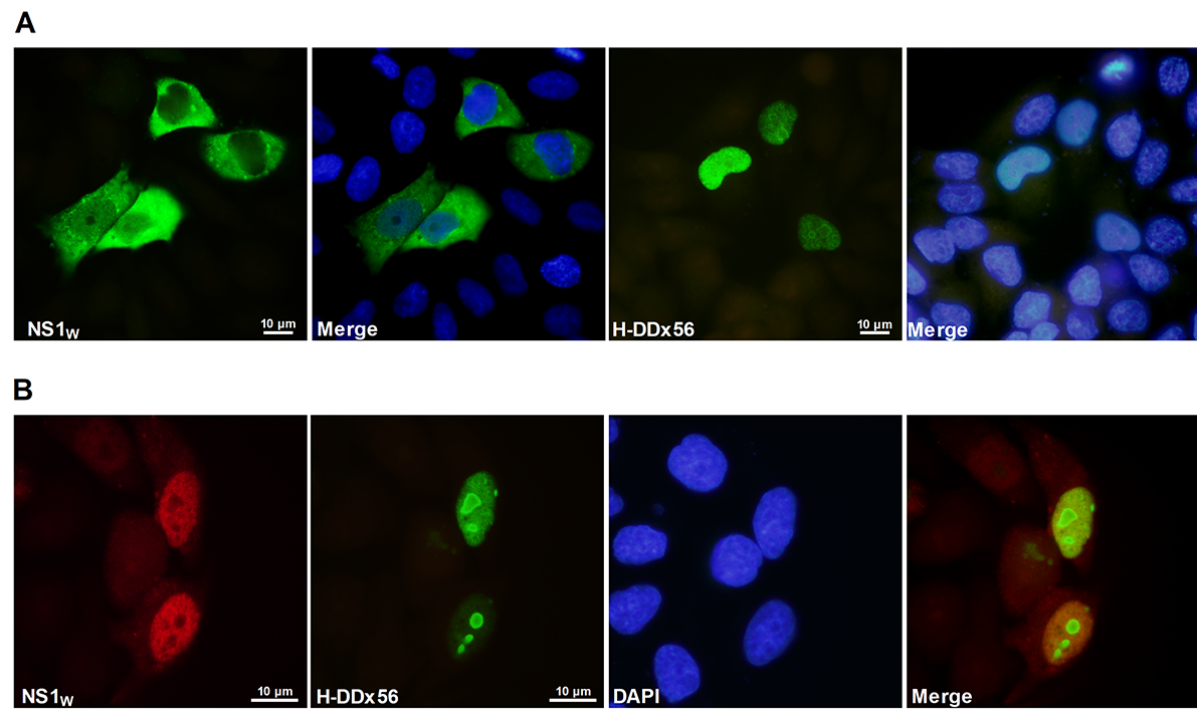
Figure 3 – Localization patterns of influenza A virus NS1 and human DDX56 proteins in HeLa cells transfected with a single plasmid ( A ) or double plasmid DNAs ( B ). The cells were fixed with 3% paraformaldehyde and immunostained with specific antibodies after 36 hours post-transfection. As primary antibodies, mouse monoclonal anti-HA (for H-DDX56) and/or rabbit polyclonal anti-NS1 (for NS1 monoclonal anti-mouse IgG conjugated Alexa-488 (for H-DDX56) and the monoclonal anti-rabbit IgG conjugated Alexa-488 or Alexa-568 (for NS1 proteins) were used. The nuclei of the cells were stained with DAPI. The samples were examined with X100 oil immersion objective. Images were captured using a fluorescence microscope (Olympus BH40,